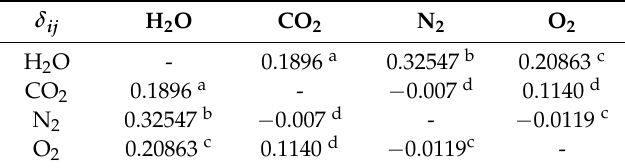
Table 2. Binary interaction parameters for PR EOS.